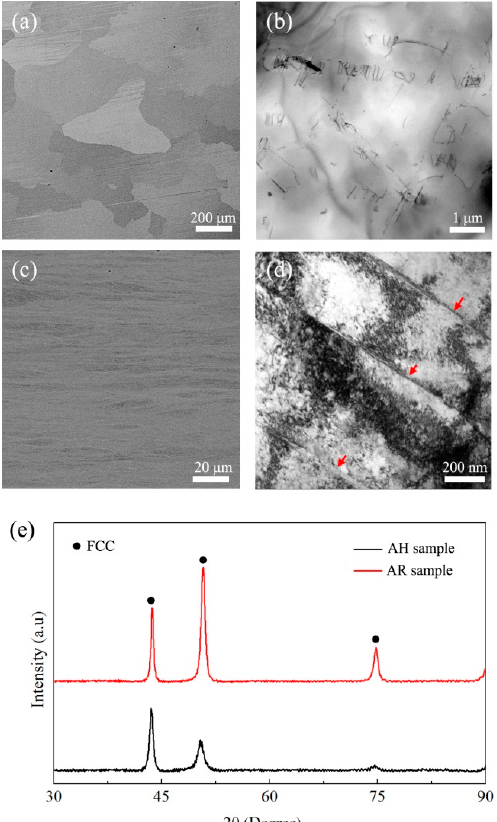
Figure 1. ( a ) SEM image of AH sample; ( b ) TEM image of AH sample; ( c ) SEM image of AR sample; ( d ) TEM image of AR sample; ( e ) XRD patterns of various samples.